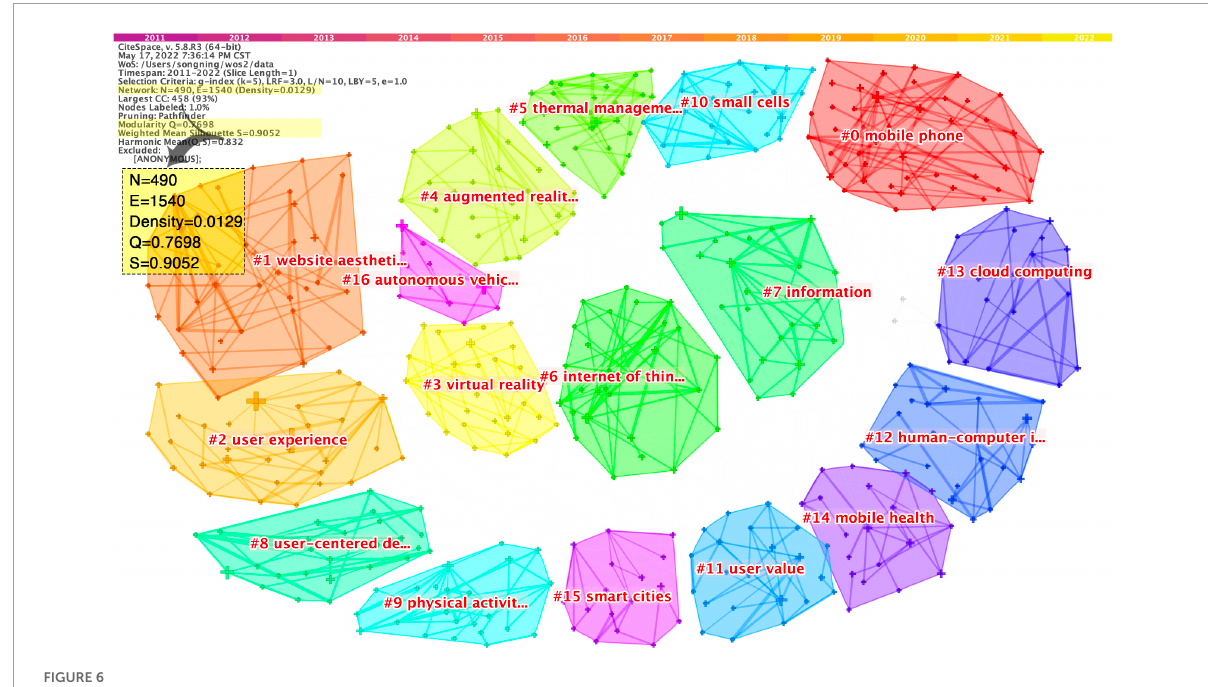
FIGURE6 Keywords clustering